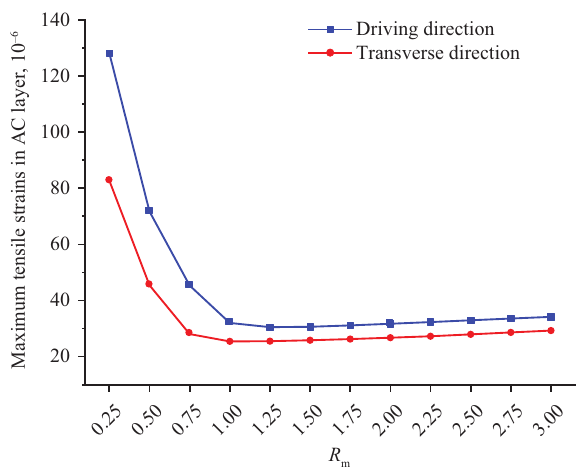
Figure 5. The maximum tensile strains in the AC layer